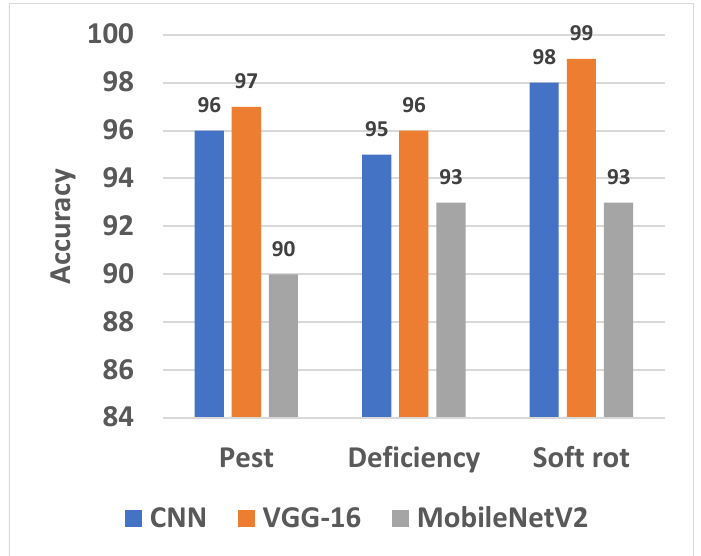
Figure 6. Performance of the proposed models in terms of accuracy.